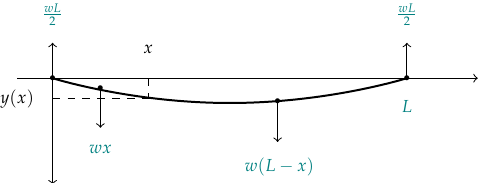
Figure 7. Beam with both ends fixed—uniformly distributed